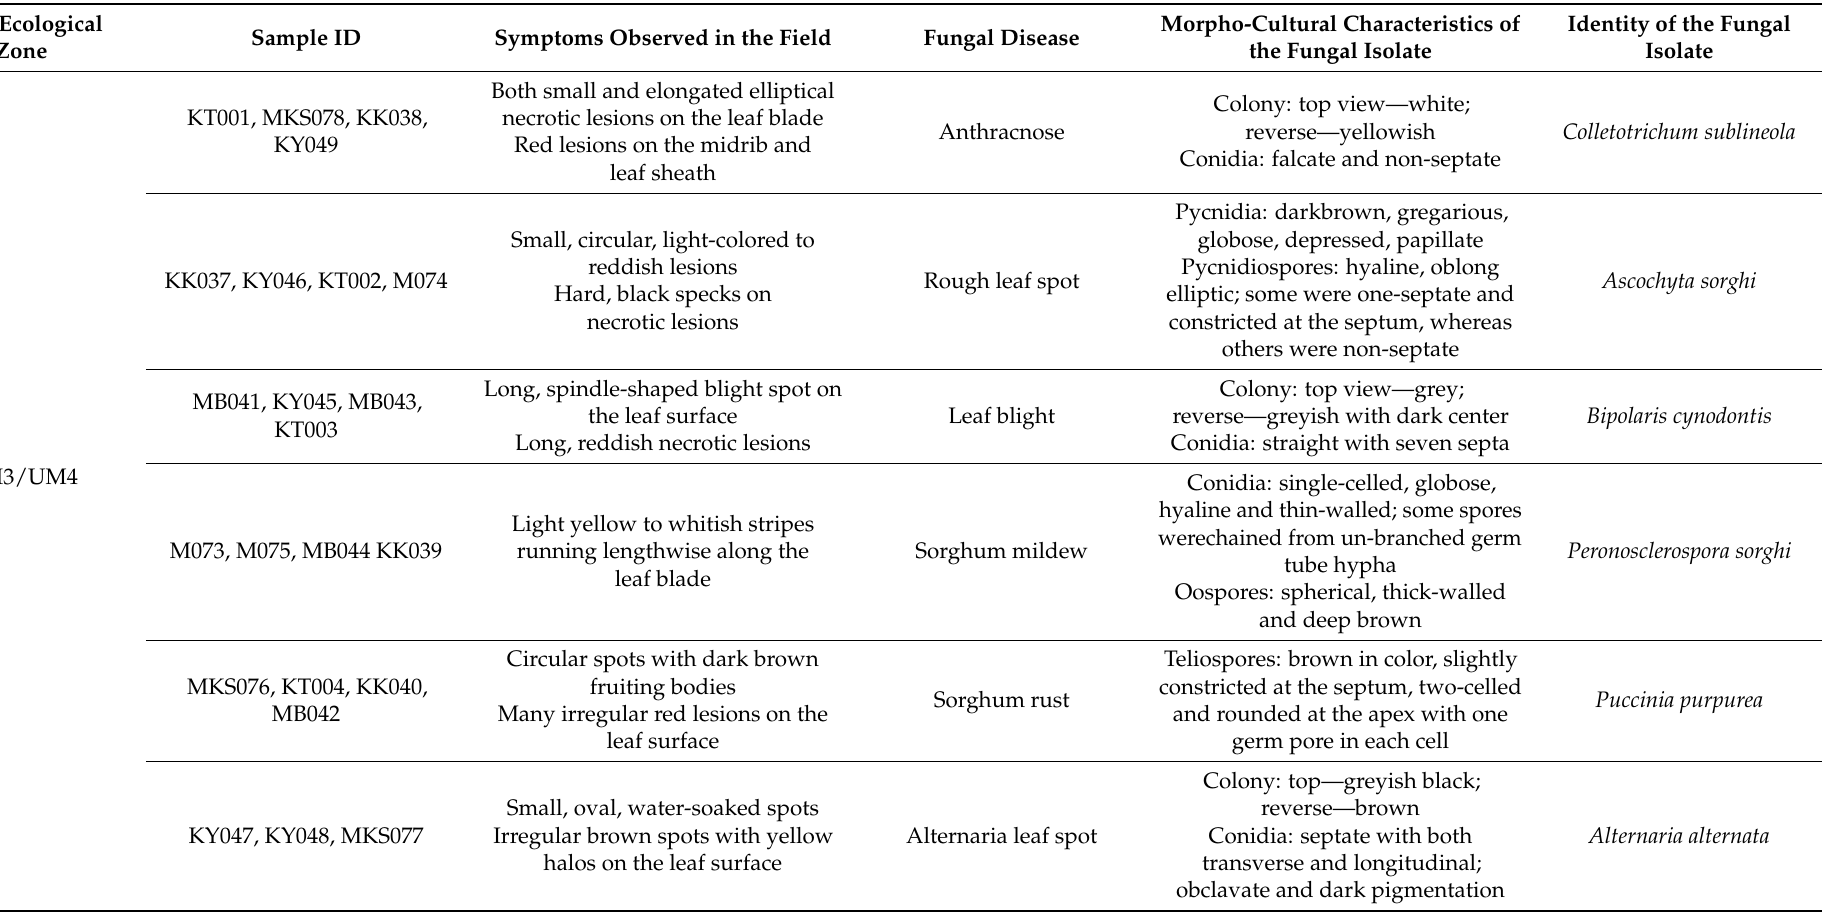
Table 5. Morphological characteristics of pathogenic fungal isolates observed on PDA after 7 days at approximately 25 ◦ C under microscopic examination.